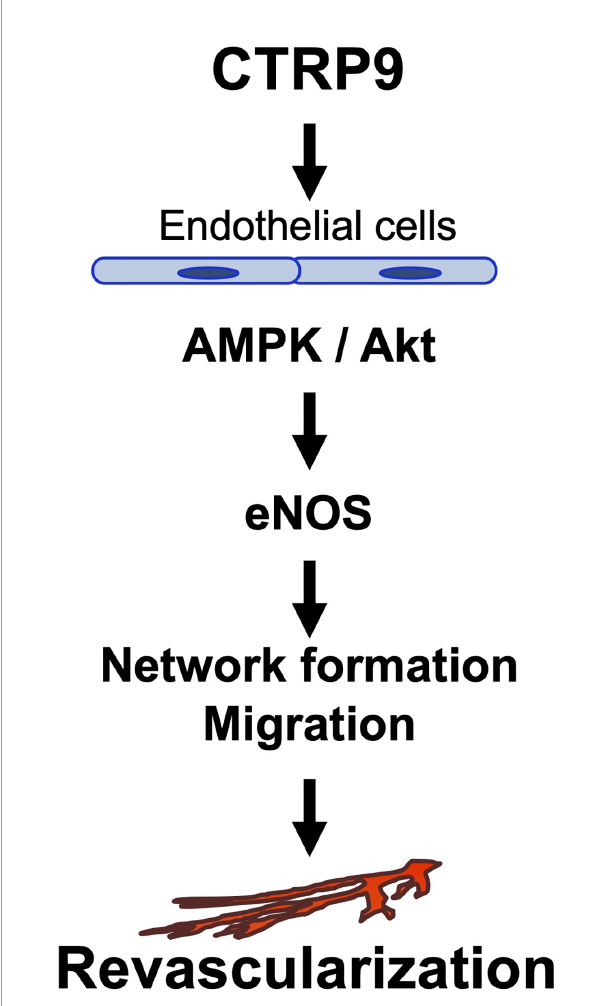
FIGURE 6 | Proposed scheme for the angiogenic actions of